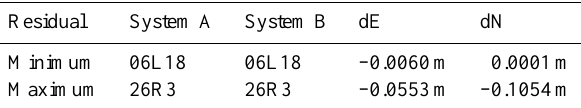
Table 3. Minimum and maximum residuals obtained from the transformation from D¨uzce to Bolu, piers 1 to 35.